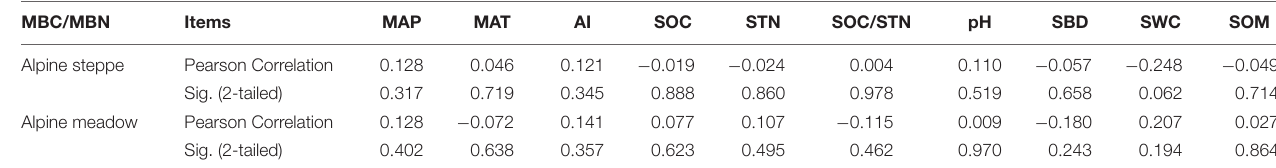
TABLE 1 | Correlations between the ratio of soil microbial biomass carbon to nitrogen (MBC/MBN) and environmental factors in alpine steppe and meadow; environmental factors include mean annual precipitation (MAP), mean annual temperature (MAT), aridity index (AI), soil organic carbon (SOC), soil total nitrogen (STN),